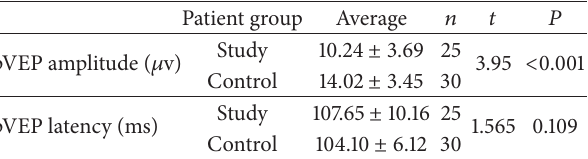
Table 3: Pattern VEP